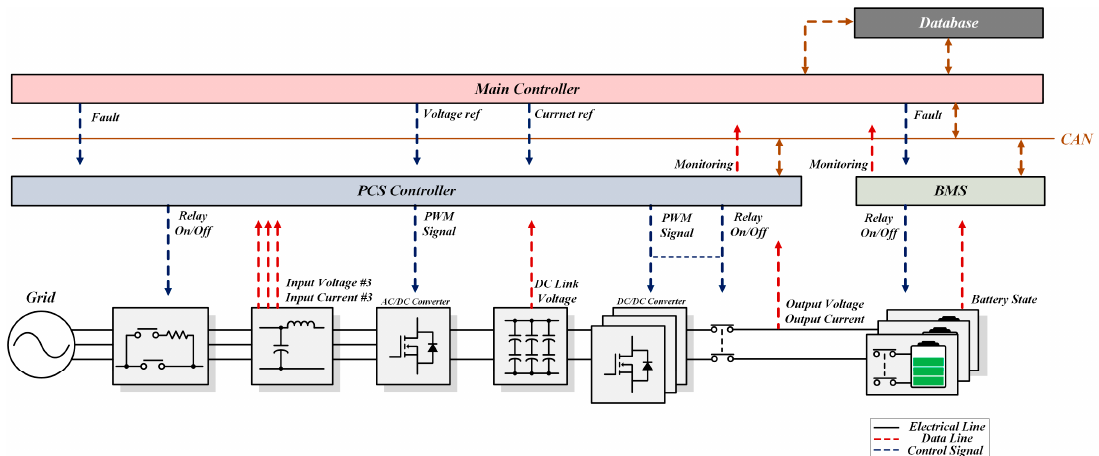
Figure 12. Control sequence of ESS for high reliability and safety.